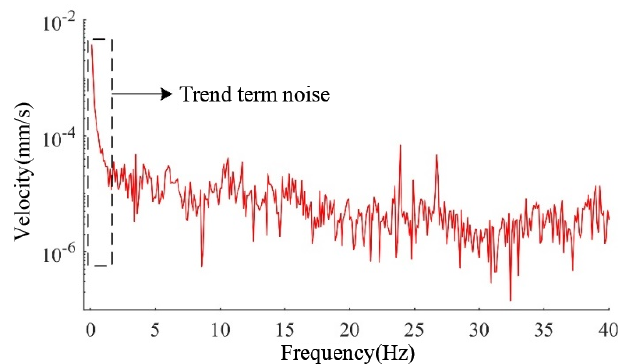
Figure 1. Vibrational velocity spectrum with low frequency